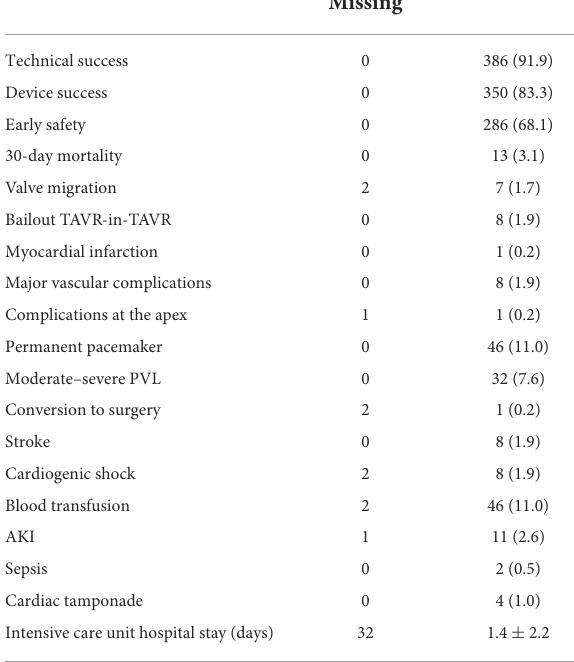
TABLE 2 Early outcome of LFLG TAVR group.